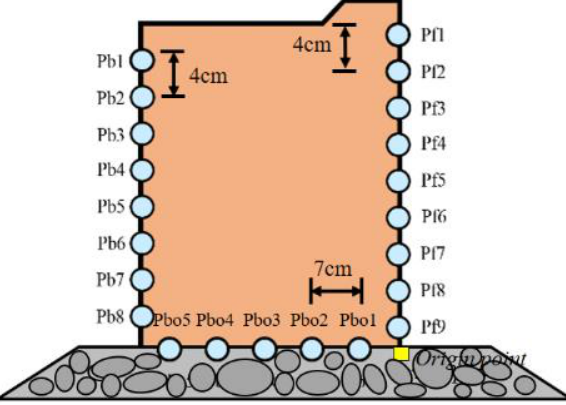
Figure 2. Position of pressure transducers on caisson breakwater.